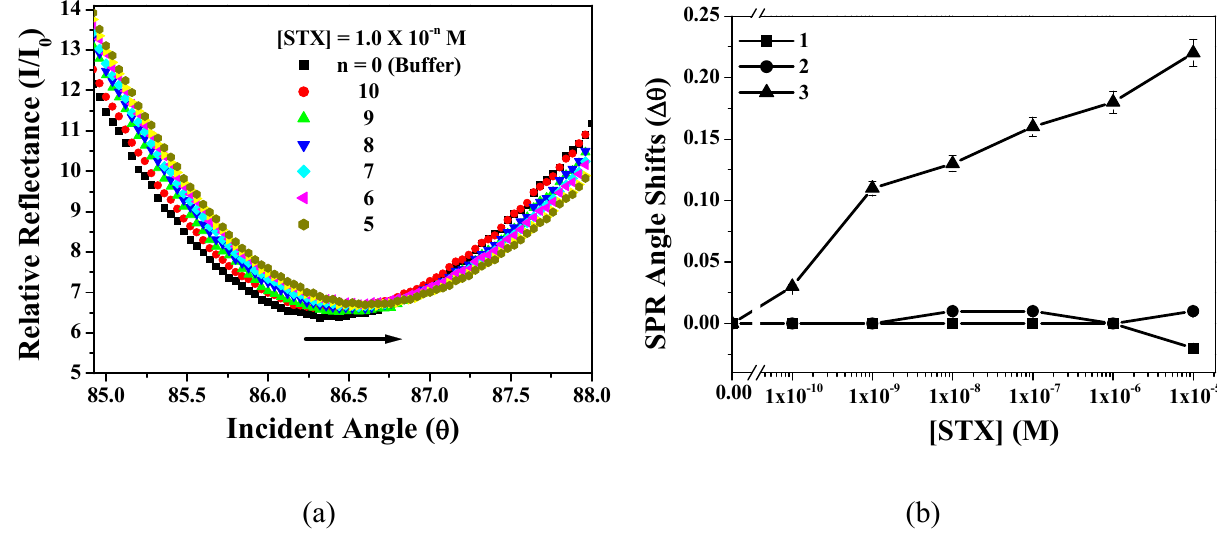
Figure 4. (a) SPR spectra of 3 SAM in the presence of various concentrations of STX; (b) relative SPR angle shifts of calix[4]arene derivatives corresponding to the presence of various concentration of